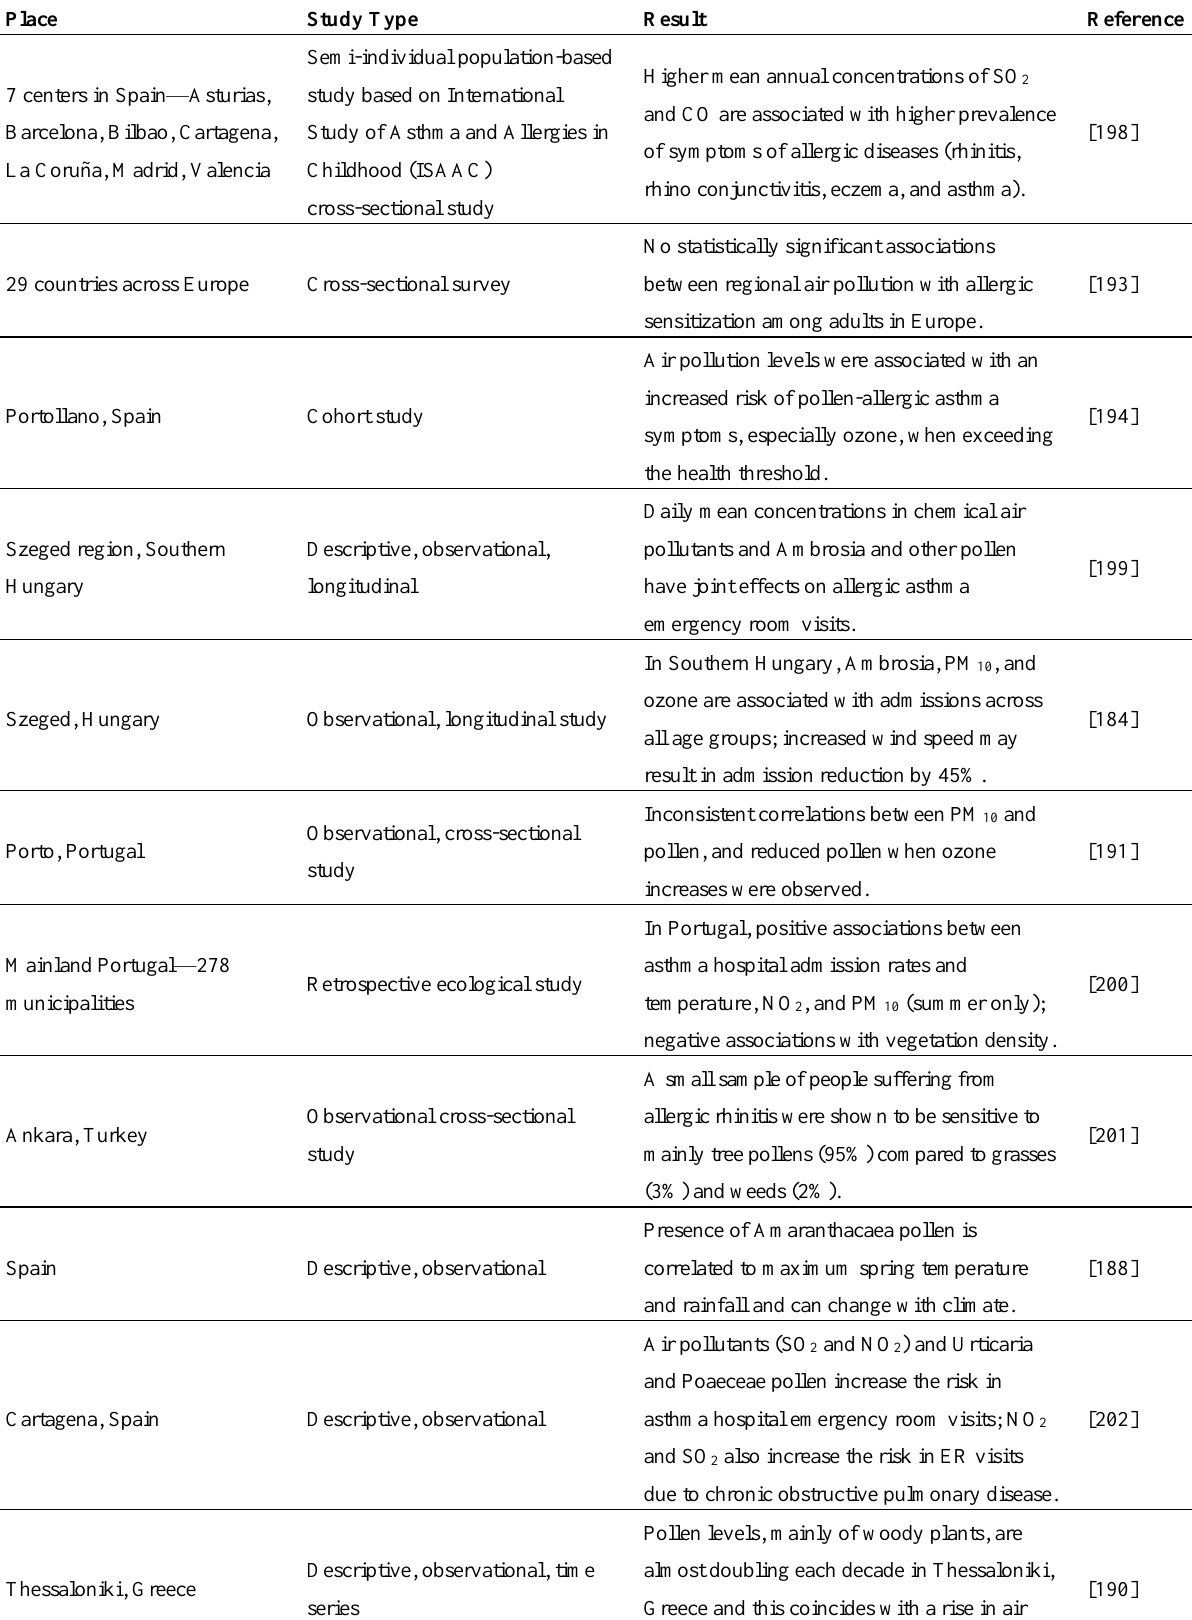
Table 10. Search results (17) on climate change and allergic